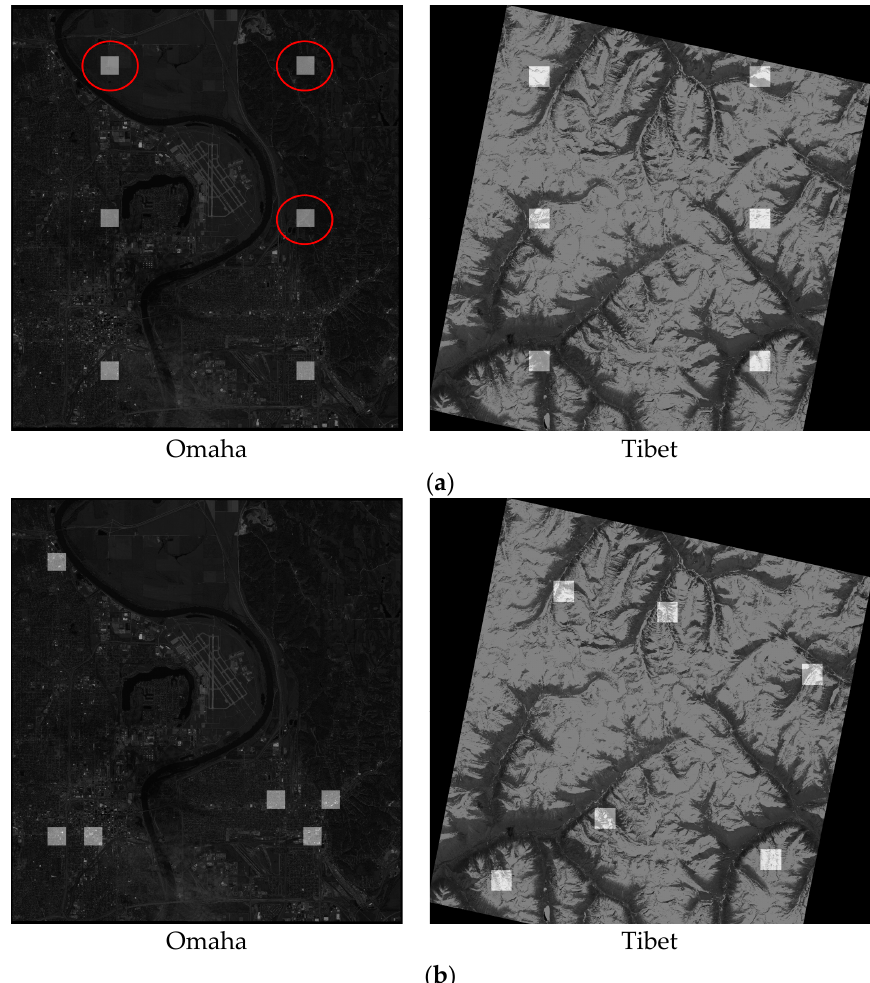
Figure 10. Image block distributions of SFB and the proposed method. ( a ) SFB. ( b ) The proposed method.